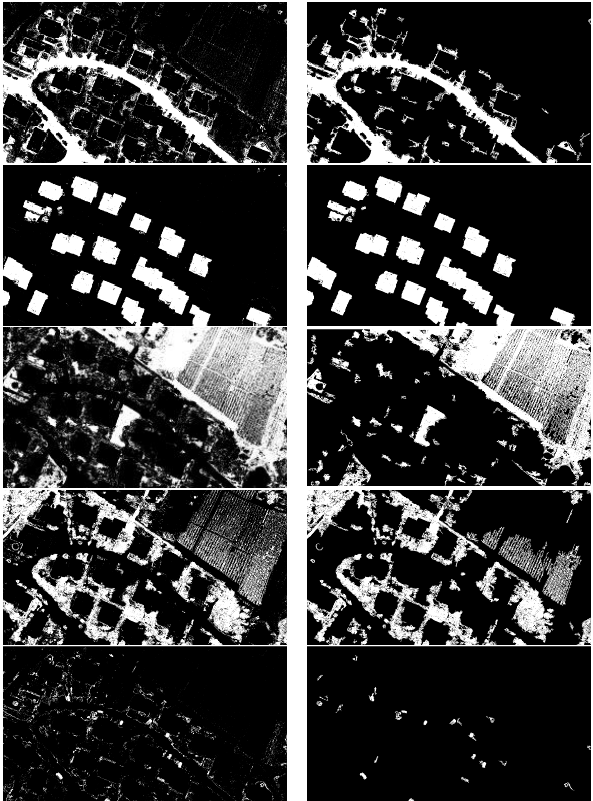
Figure 4. Binary map for each class (Left column) and enhanced binary map by filtering small patches (Right